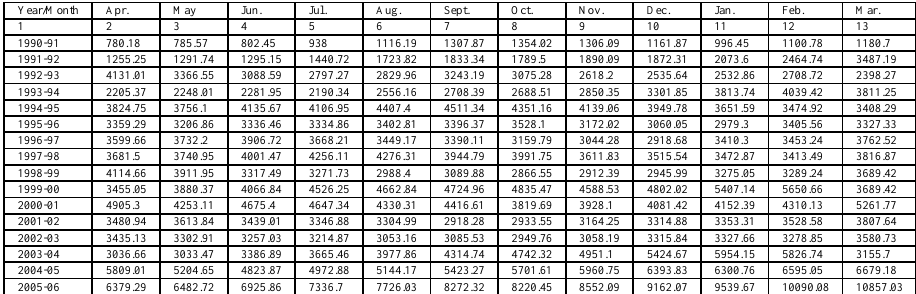
Table 1. Monthly average of BSE sensex